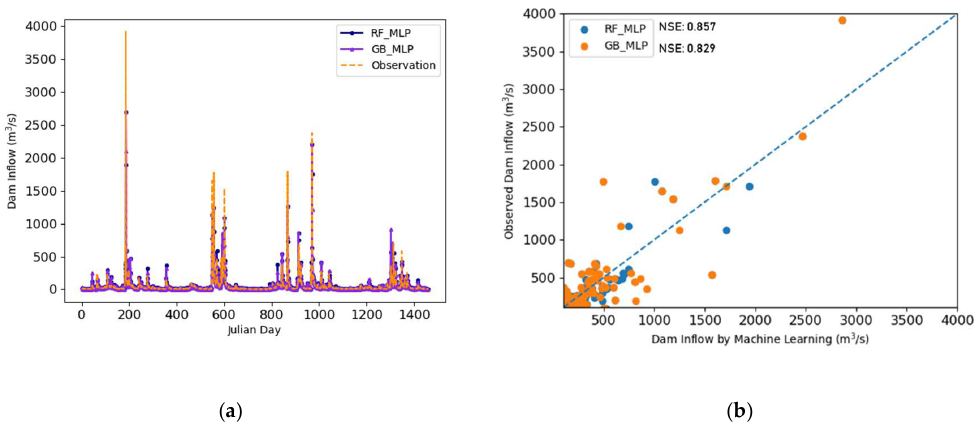
Figure 11. Comparison of predictive results by input data in multilayer perceptrons model: ( a ) dam inflow prediction with observed dam inflow below 100 m 3 /s; ( b ) dam inflow prediction with observed dam inflow over 100 m 3 /s. Table 6. Prediction accuracy results of combined machine learning (CombML) models.